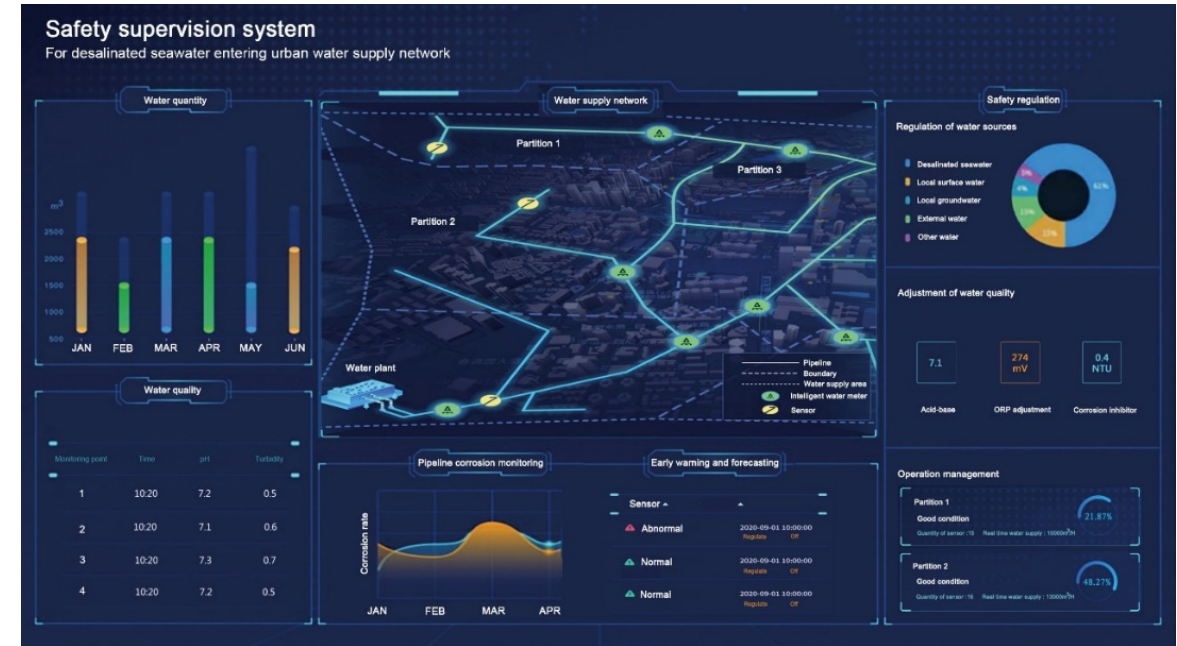
Figure 2. Interface of the supervision system.